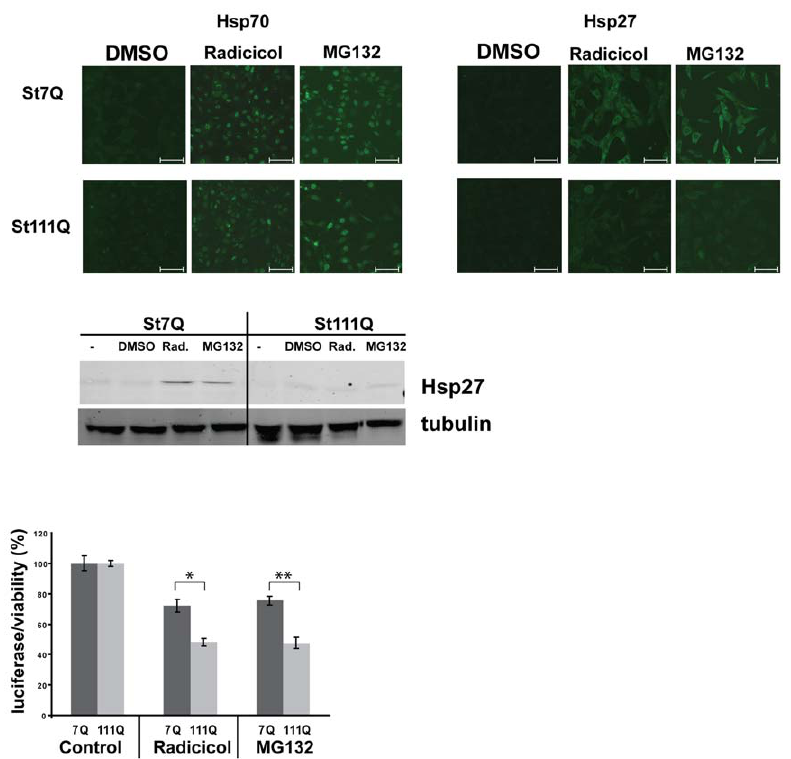
Figure 3. Decreased resistance to inhibition of the proteasome or Hsp90 in cells expressing polyQ-expanded Htt. A ) Immunofluorescence microscopy of STHdh(Q7) and STHdh(Q111) cells that were treated for six hours with the Hsp90 inhibitor radicicol (5 m M) or the proteasome inhibitor MG132 (10 m M) using anti-Hsp70 and anti-Hsp27 antibodies. The scale bars represent 75 m m B ) Western blots prepared from protein lysates treated as in A. C ) Viability assay (luciferase activity, Promega) of STHdh(Q7) and STHdh(Q111) cells that were treated with DMSO (control), radicicol (5 m M), or MG132 (10 m M) for six hours. The error bars represent SD. Results from four independent experiments were analyzed. * p , 0.001 and **p , 0.005 (two tailed